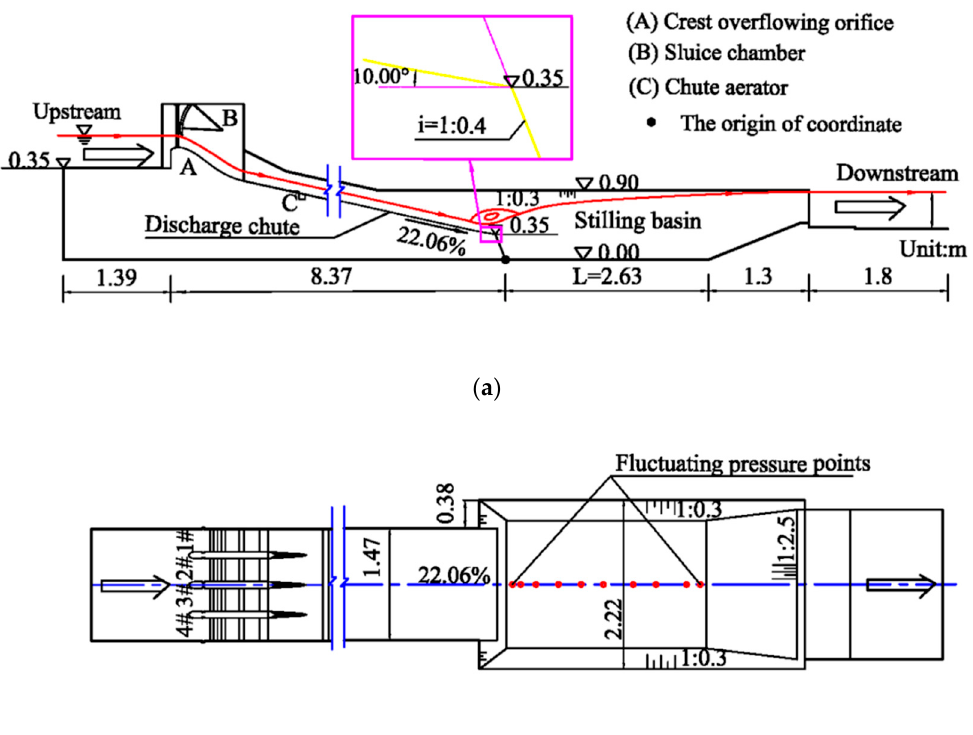
Figure 1. Schematic design of model test: ( a ) Sectional view; ( b ) Plan view.